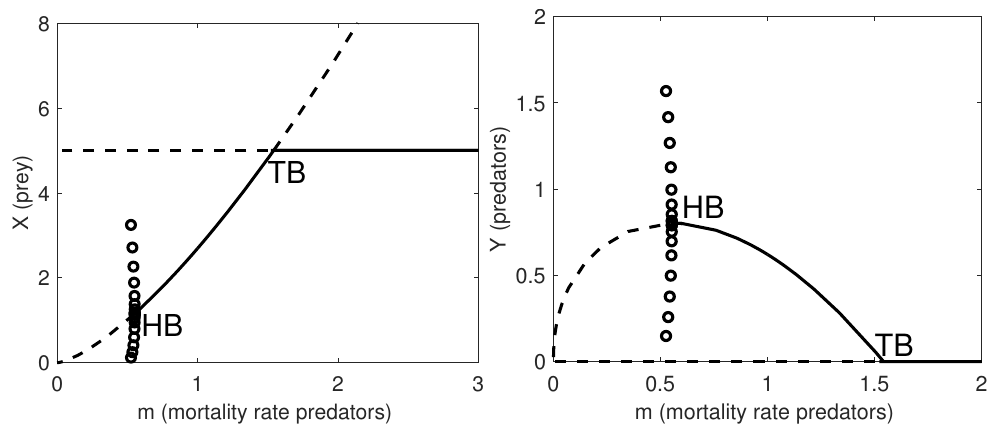
Figure 1. One-parameter bifurcation diagram with respect to m . Left panel : the prey population dynamics. Right panel : the predator population dynamics. Thick lines: stable equilibria; dashed lines: unstable equilibria; HB: supercritical Hopf bifurcation point where a stable limit cycle arises with maximum amplitude given by the amplitude of the HB (circles); TB: transcritical bifurcation point where the coexistence equilibrium exchanges its stability with the prey-only equilibrium. The remaining parameter values are as in Table 6.